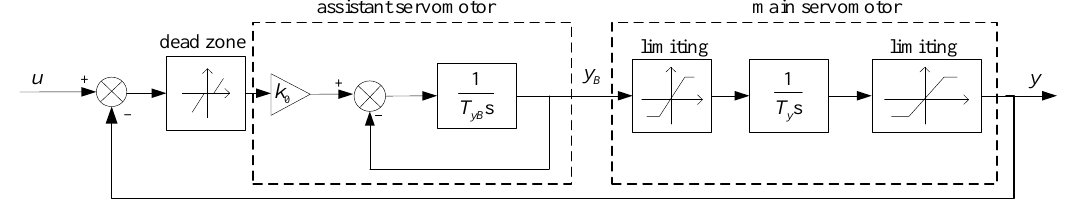
Figure 4. Structure of the servomechanism.